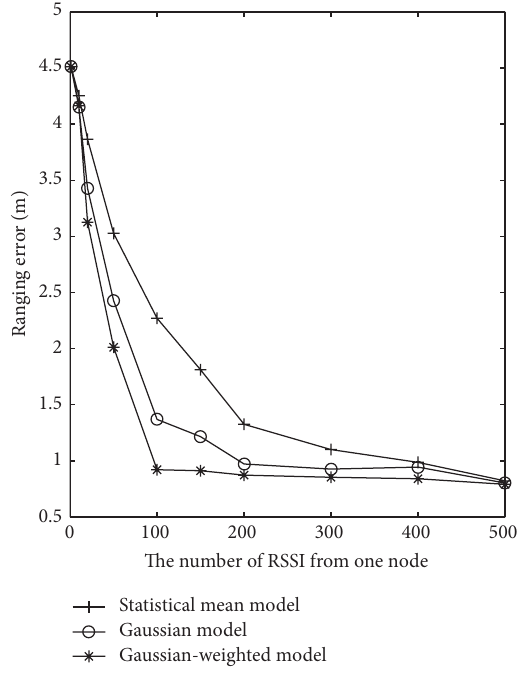
Figure 2: Relationship between the number of RSSI of a single node and ranging error.